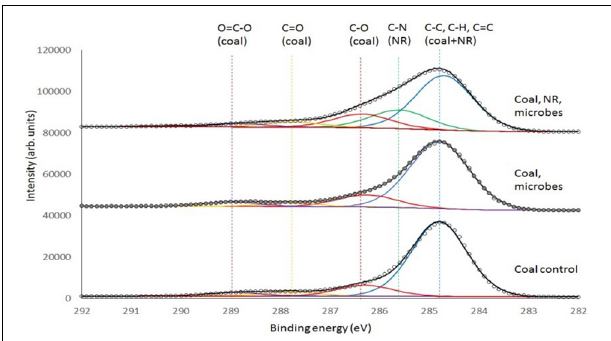
FIGURE 7 | Deconvoluted XPS spectra of Jharia coal as control, Jharia coal with groundwater, and Jharia coal treated with groundwater and neutral red. Carbon chemical state assignments are color coded and generally common between samples with the exception of C-N that is only present in the sample with neutral red